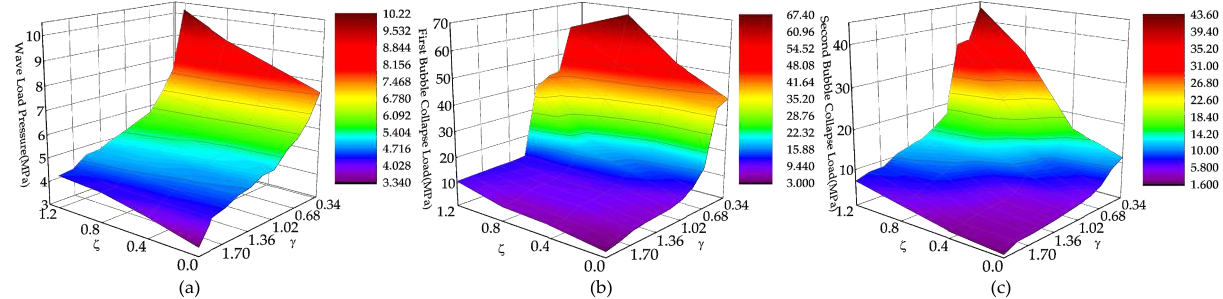
Figure 20. Load trend for 0.33 ≤ γ ≤ 2.00 and 0 ≤ ζ ≤ 1.2. (3D): ( a ) 3D graph of shock wave pressure load changing with ζ and γ; ( b ) 3D graph of first bubble collapse load changing with ζ and γ; ( c ) 3D graph of second bubble collapse load changing with ζ and γ.